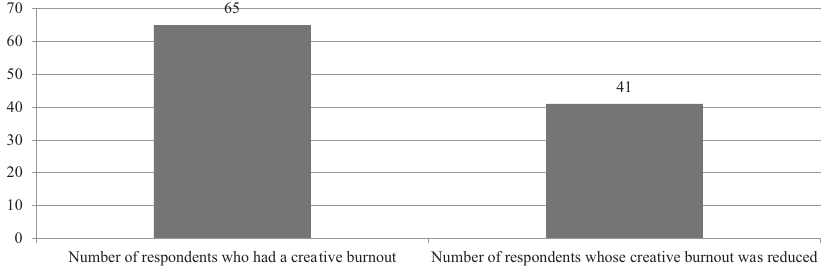
Figure 4. The decomposition of the first level of the context diagram of the functional model idef0 of reducing creative burnout (source: created by